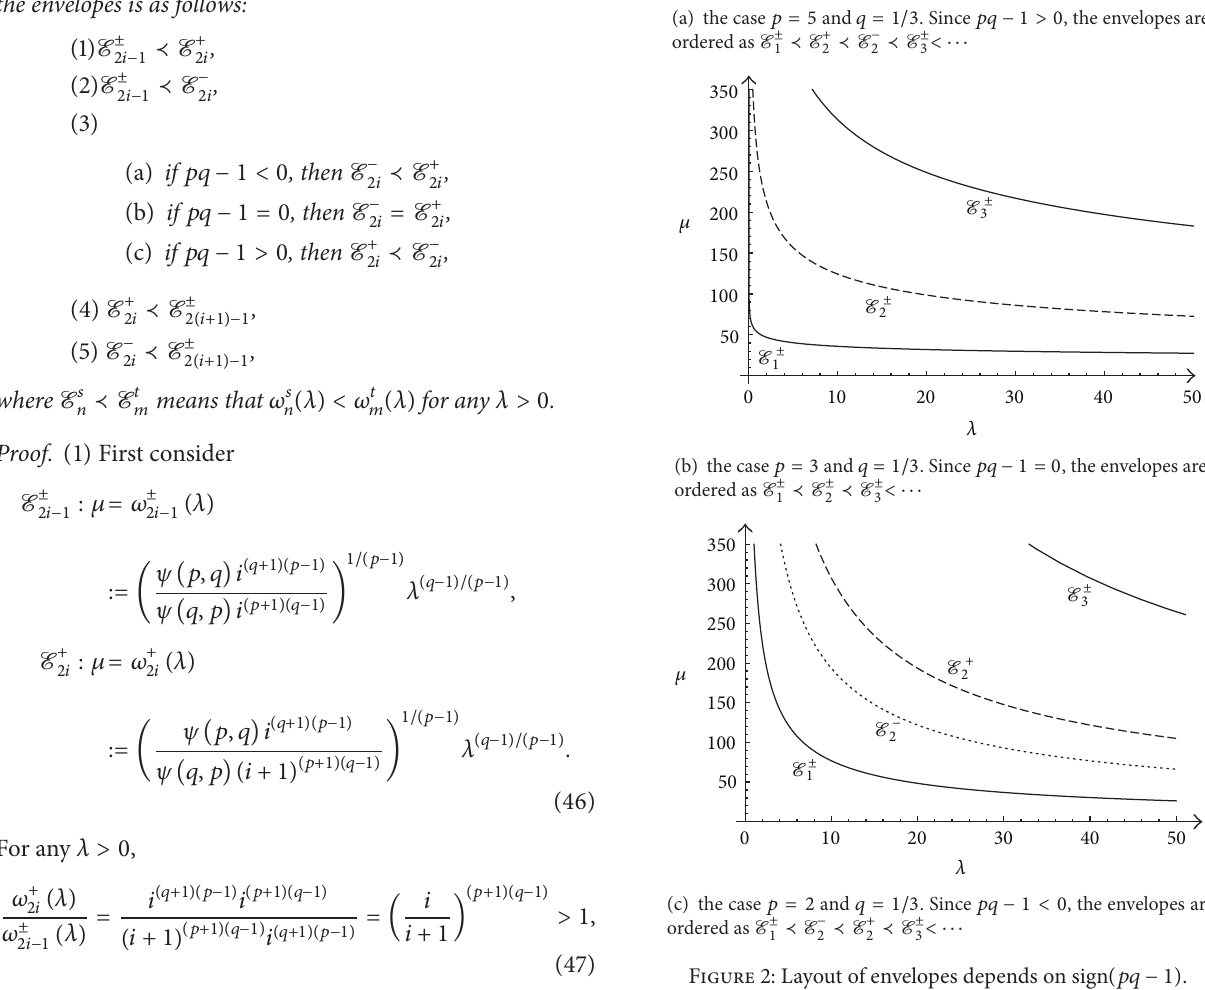
Figure 2: Layout of envelopes depends on sign (𝑝𝑞 − 1)